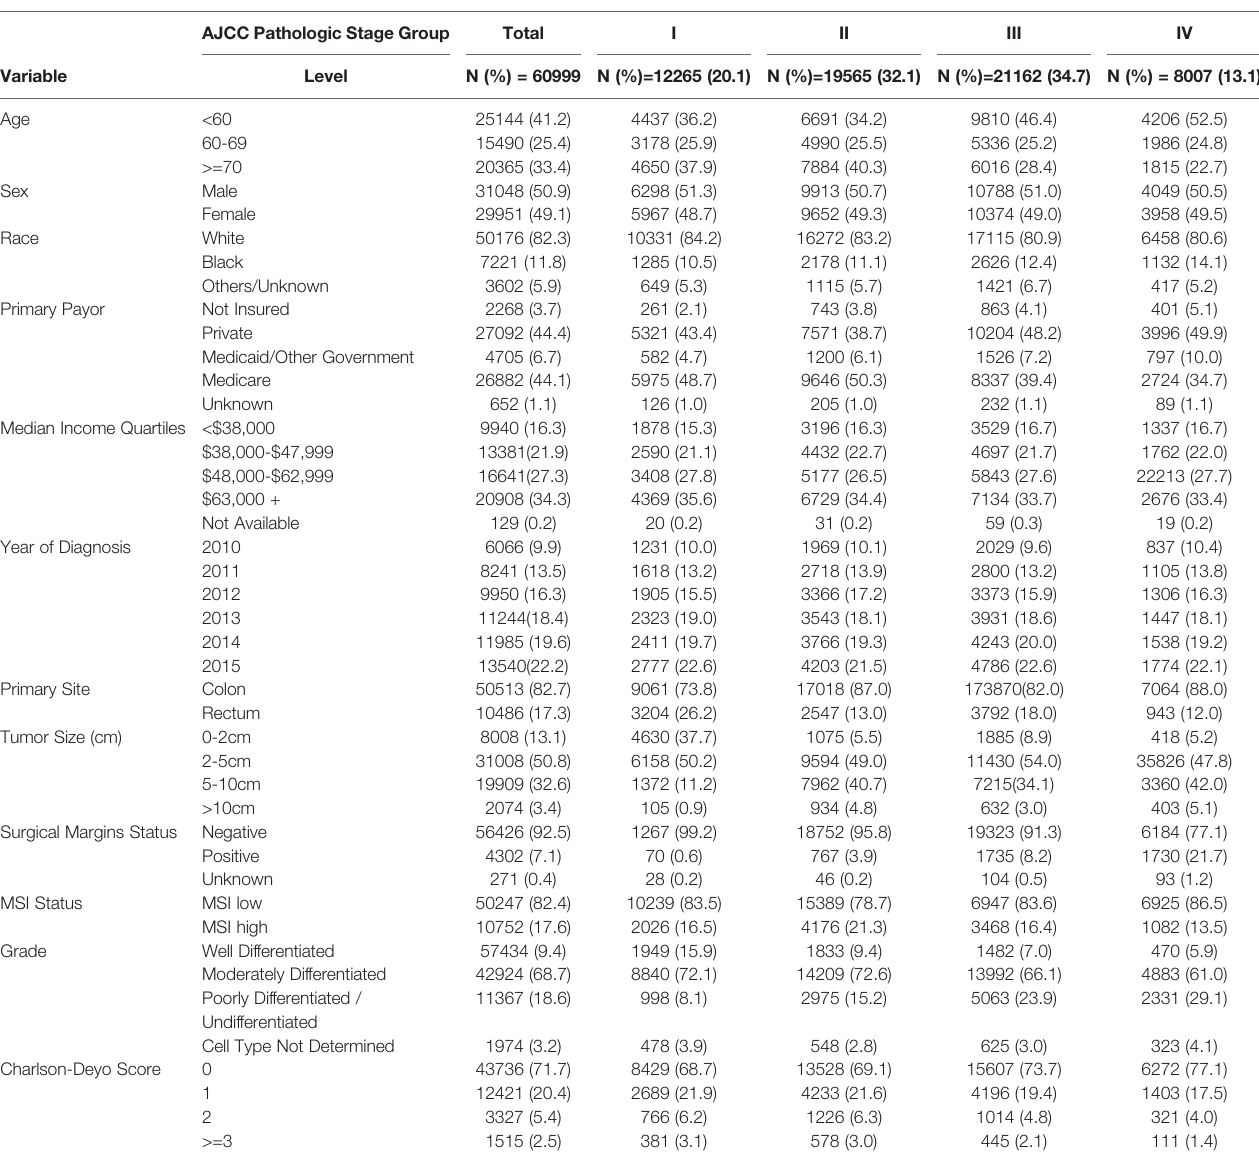
TABLE 1 | Demographics of study